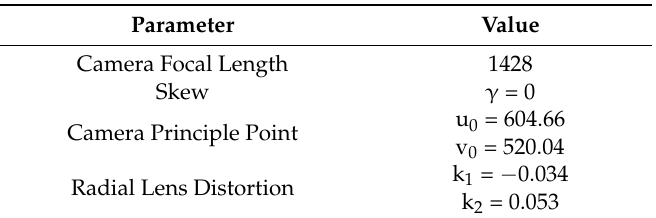
Table 1. Camera calibration parameters.